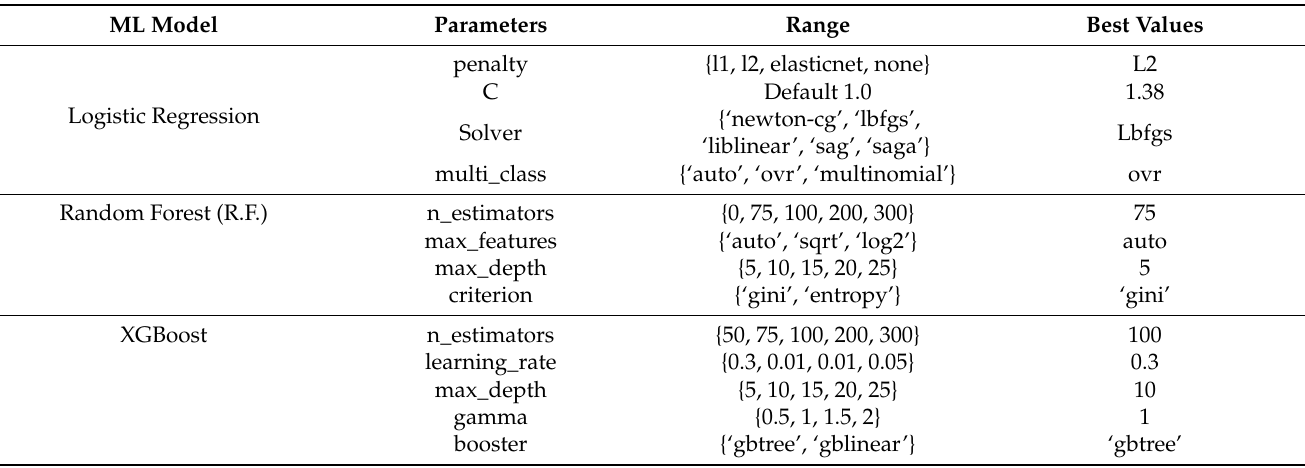
Table 3. Optimized hyperparameters for ML classifier models.